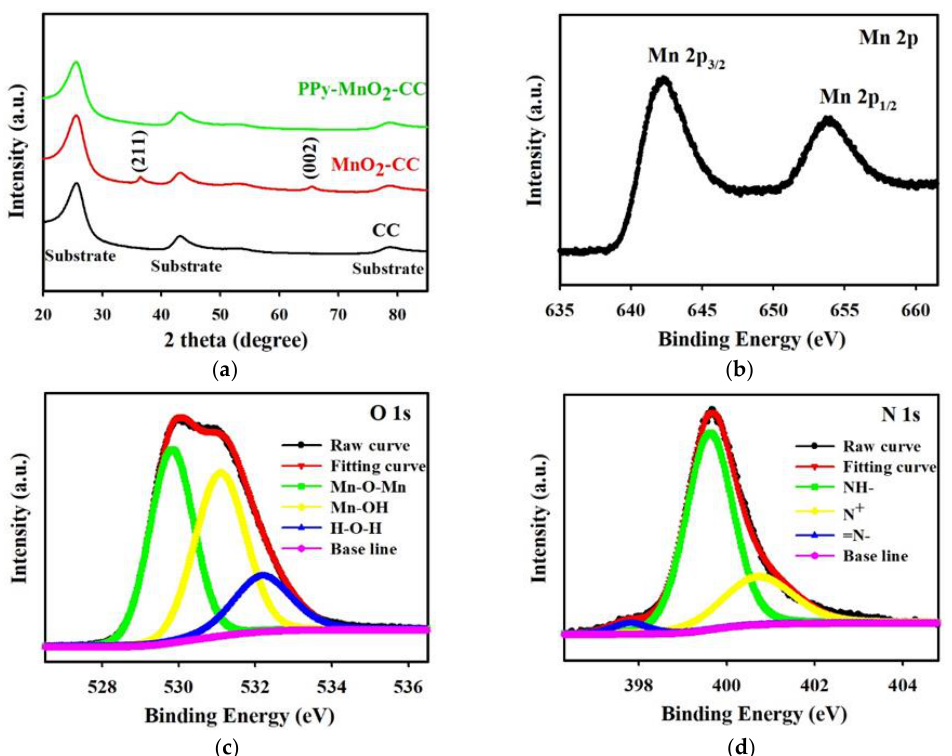
Figure 3. ( a ) XRD patterns of blank CC, MnO 2 -CC, and PPy-MnO 2 -CC electrodes, respectively. XPS spectra of ( b ) Mn 2p, ( c ) O 1s, and ( d ) N 1s of the as-prepared PPy-MnO 2 -CC electrode.